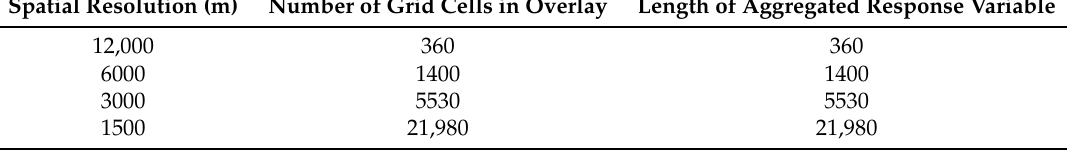
Table 2. The size of the pre-processed data set varies according to coarseness of the spatial aggregation